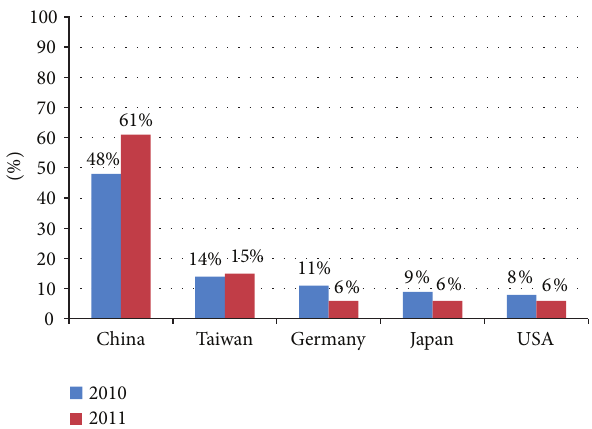
Figure 4: 2010-2011 global solar photovoltaic production capacity. Source: PIDA (2012) [1].